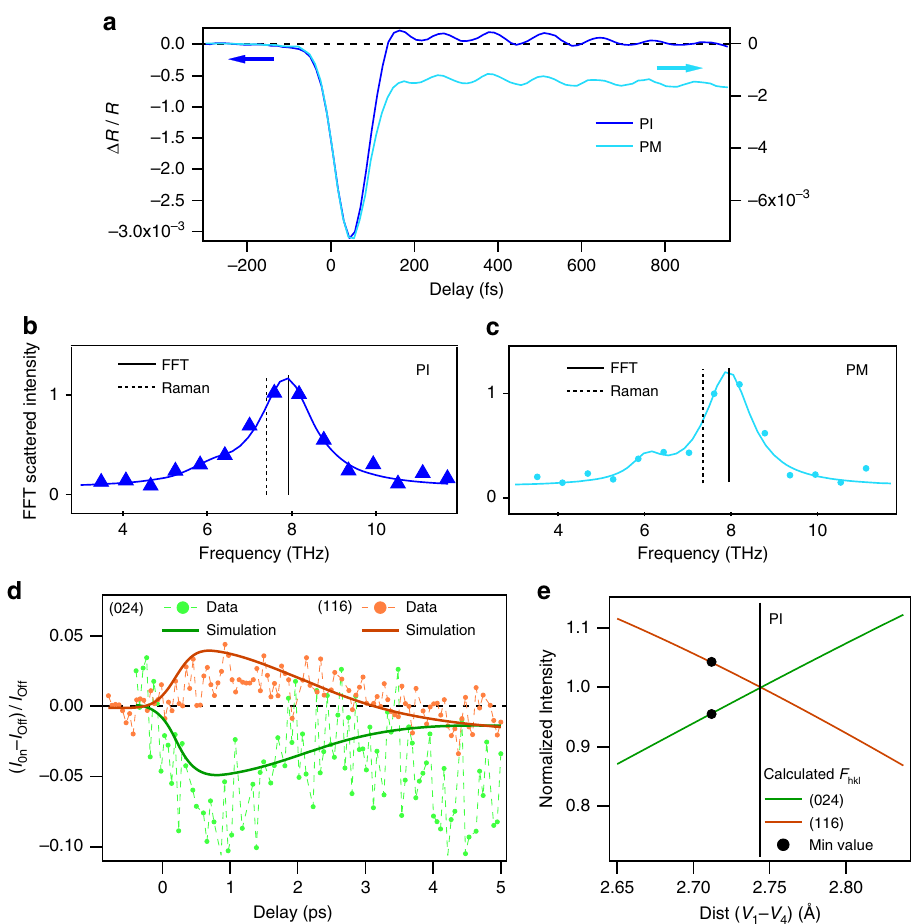
Figure 3 | Experimental results from TRR and trXRD. ( a ) TRR traces for (V 1 (cid:2) x Cr x ) 2 O 3 ( x ¼ 0.028 PI and x ¼ 0 PM) for a fluence of 8mJcm (cid:2) 2 : the A 1 g coherent phonon is clearly visible. ( b , c ) Fast Fourier transform of TRR traces compared with equilibrium Raman spectroscopy for the PM phase and PI phase, respectively. The A 1 g pump–probe frequencies (full) present a clear blue-shift compared with the equilibrium frequency (dashed) in both phases. ( d ) trXRD measurements in the PI phase for a fluence of 8mJcm (cid:2) 2 , showing the pump–probe diffraction peak intensities for the Bragg reflections (116) and (024). The solid lines are the simulation as explained in text. ( e ) The calculated structure factor versus the shortest vanadium distance (V 1 (cid:2) V 4 ). The black dots represent the minimum distance observed extracted from d